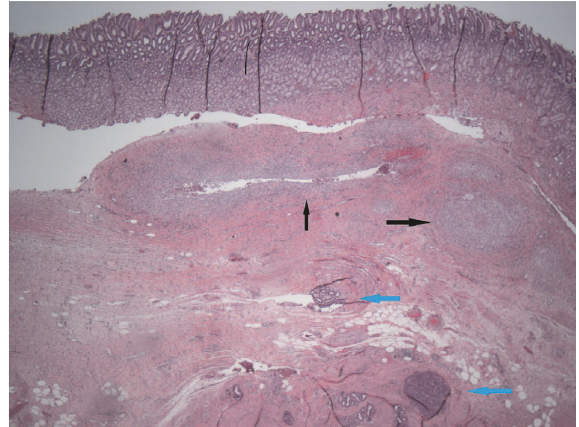
Figure 3: Gastric mucosa with underlying submucosa showing a small area of granulomatous inflammation (black arrows) and muscularis propria containing pancreatic ducts and acini (blue arrows) (H&E,